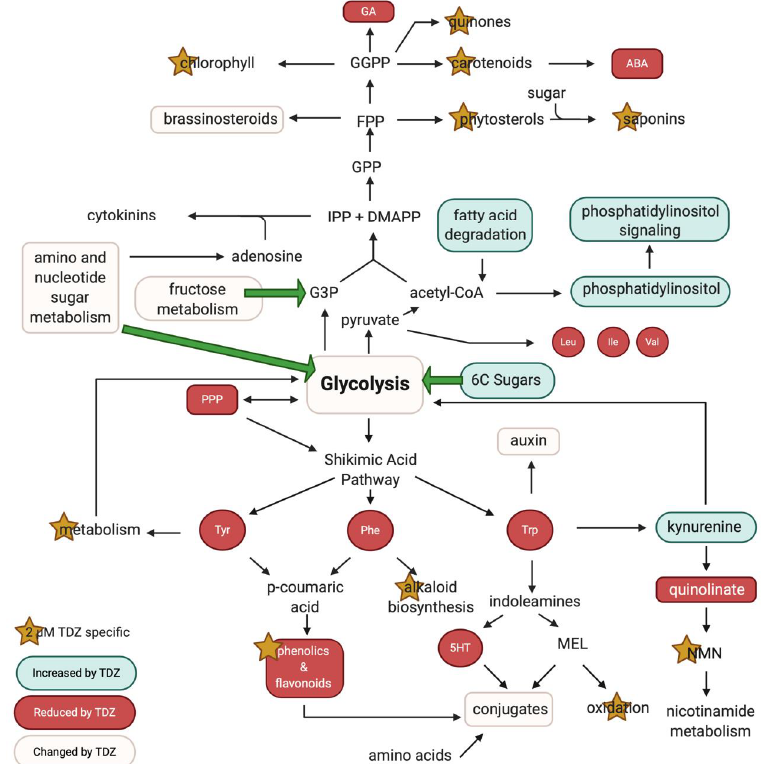
Figure 9. Thidiazuron (TDZ) mediation of glycolysis and shikimic acid derived metabolism. 5-HT, serotonin; ABA, abscisic acid; CS, coumaroylserotonin; DMAPP, dimethylallyl diphosphate; FPP, farnesyl diphosphate; GA, gibberellic acid; GGPP, geranyl geraniol diphosphate; IPP, isopentenyl diphosphate; MEL, melatonin; NMN, nicotinic acid mononucleotide; PPP, pentose phosphate pathway. Figure created in BioRender.